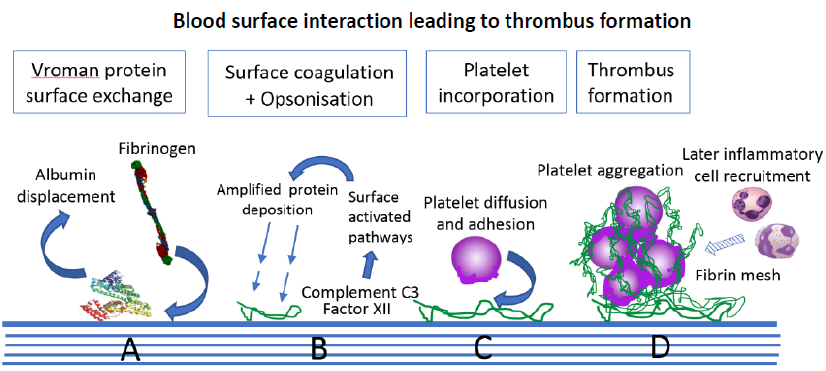
Figure 4. Schematic of surface coagulation sequence. ( A ) Initial rapid protein deposition, in milliseconds, subject complex, competitive displacement/remodeling via the Vroman effect, e.g., fibrinogen displacement of albumin. ( B ) Surface activated C3 and Factor XII trigger complement and coagulation cascades, leading to protein/C3b coating (opsonisation) and fibrin directed at the surface. ( C ) Platelets contact with coated protein sets of adhesion response. ( D ) Platelet adhesion leads to activation and promotion of fibrin clot, later inflammatory cells incorporated.